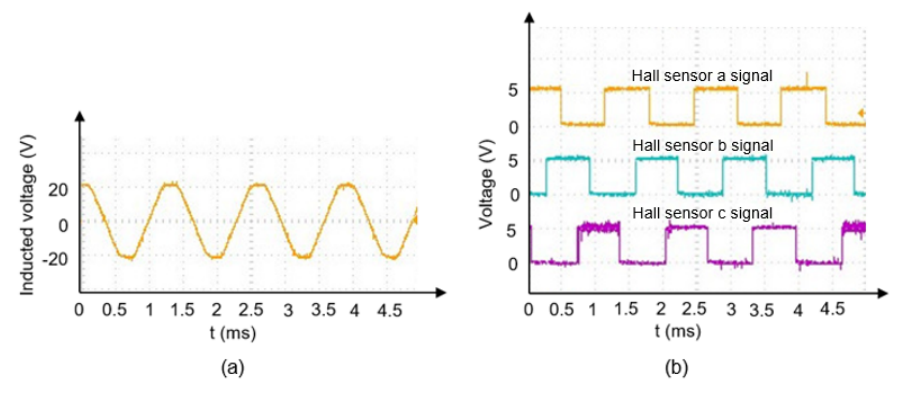
Figure 22. Oscilloscope trace of ( a ) phase a inducted EMF waveform and ( b ) signals from hall sensor board.